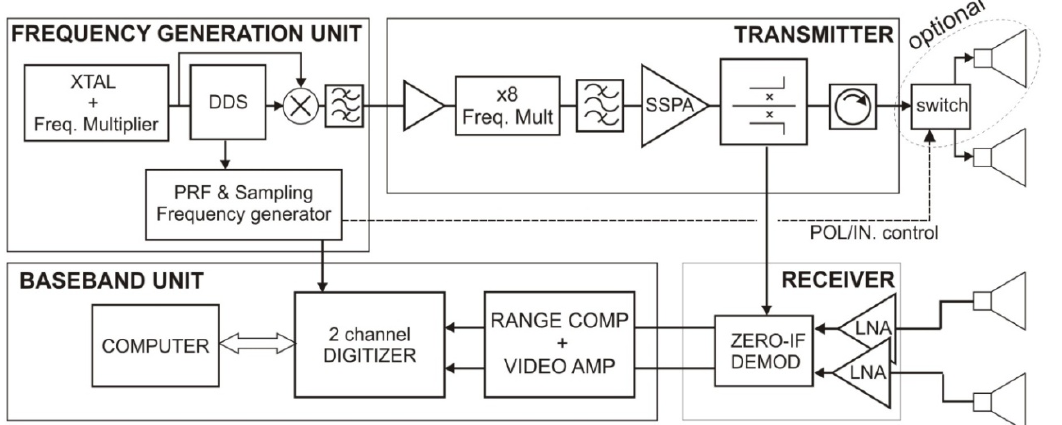
Figure 1. ARBRES-X block diagram. ARBRES-C is similar, with a different frequency multiplier ( × 4) in the transmitter